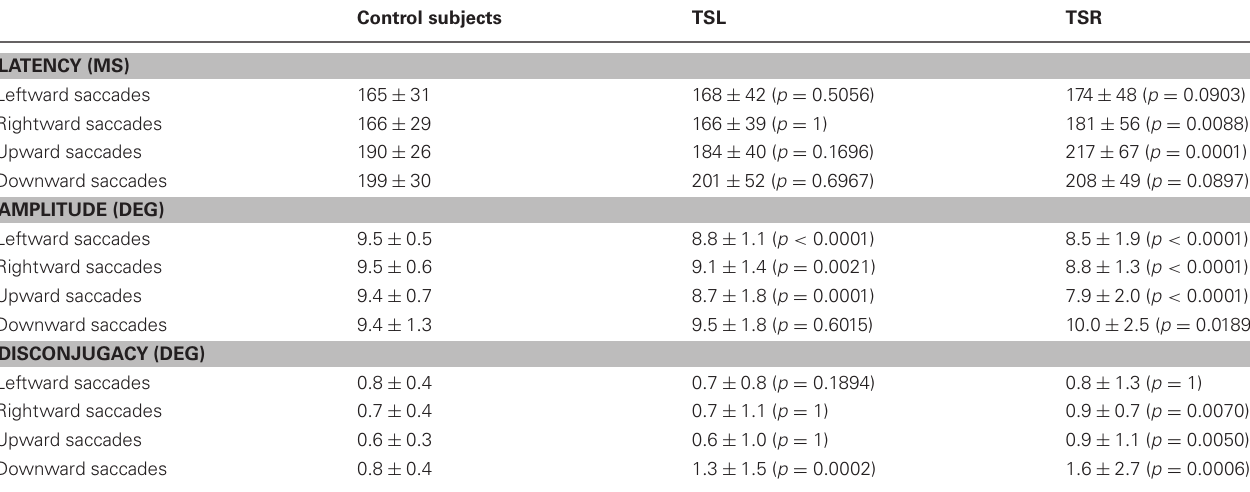
p-values from t-test comparison with control data are given for both TSL and